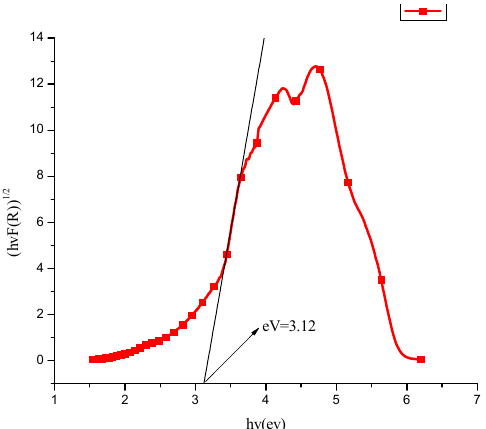
Figure 8. The solid-state diffuse reflectance UV-Vis spectra for the complex.